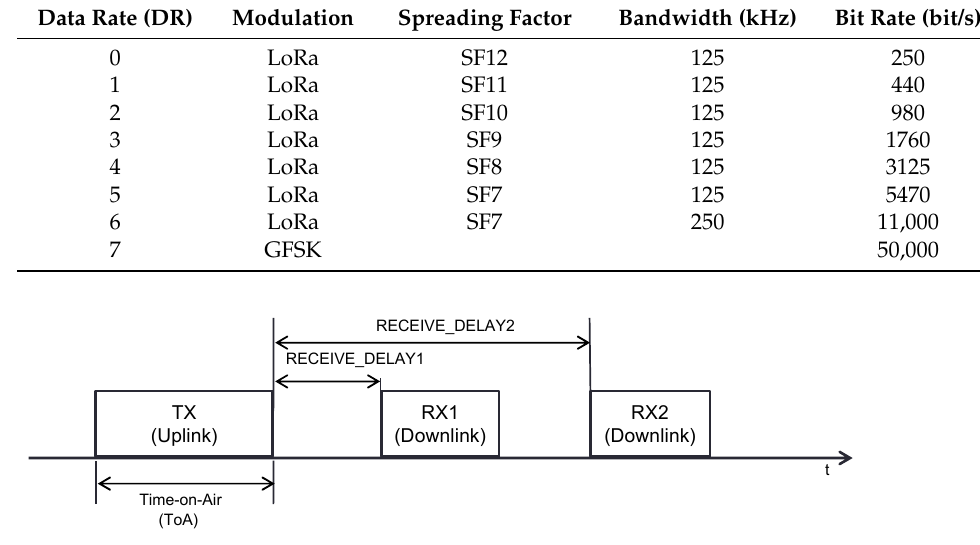
Figure 2. Uplink transmission followed by the two receive windows, RX1 and RX2, defined in LoRaWAN class A.